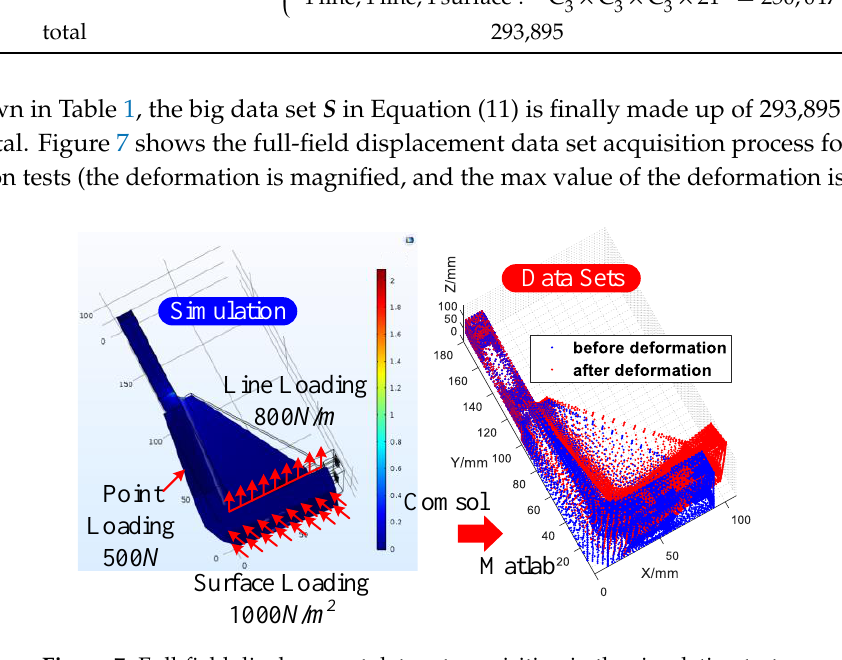
Figure 7. Full-field displacement data set acquisition in the simulation test.